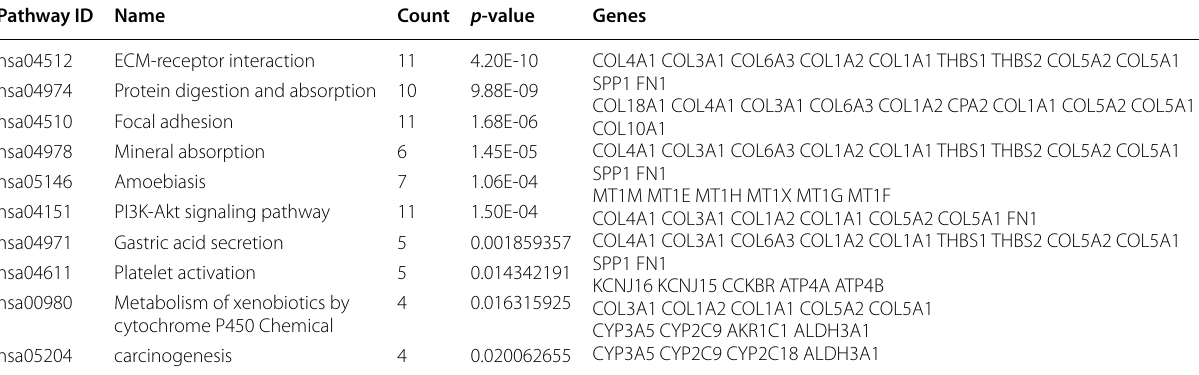
KEGG Kyoto Encyclopedia of Genes and Genomes, DEGs differentially expressed genes, ECM extracellular matrix